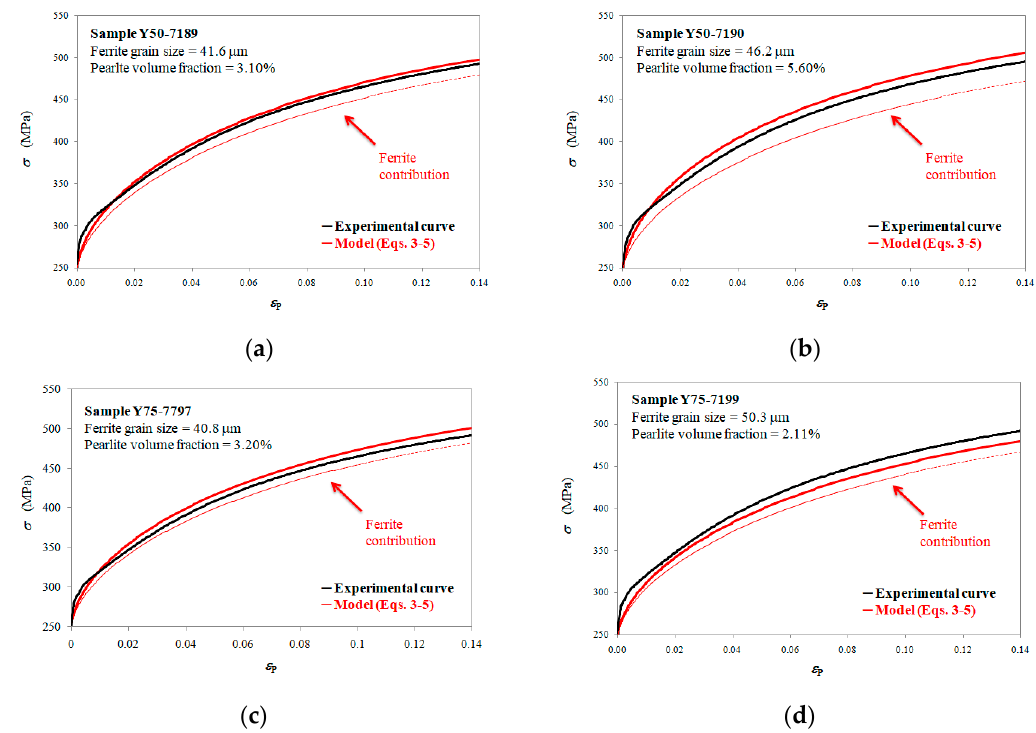
Figure 3. Examples of modelling with Equations (3)–(5) the tensile flow curve of the GJS 400 from different moulds: ( a ) and ( b ) from Y 50 mm; ( c ) and ( d ) from Y 75 mm.